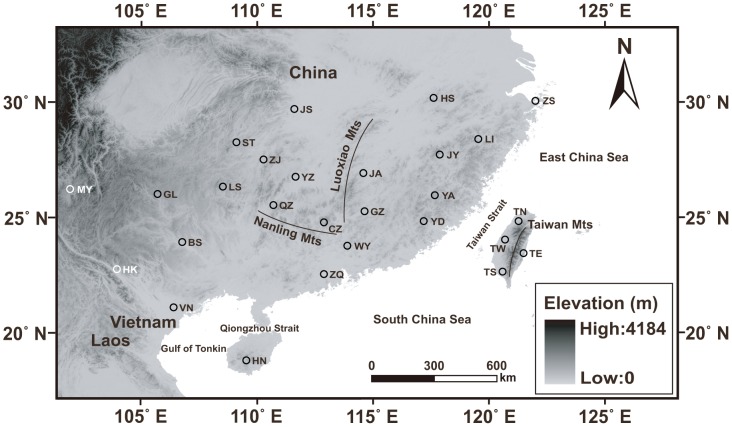
Sampling locations of Naja atra in this study.See Table 1 for sample site abbreviations. Solid lines indicate mountain series.